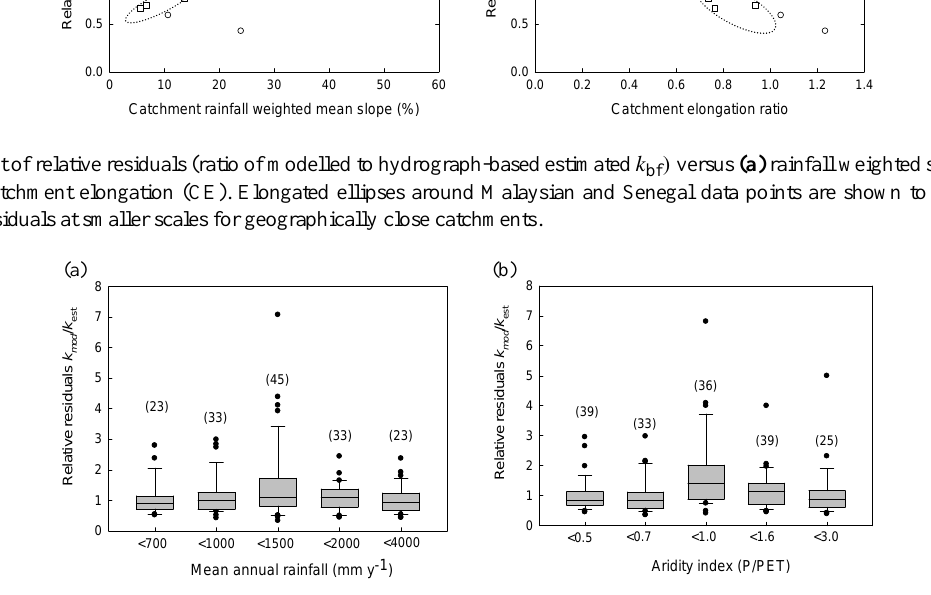
Fig. 8. Box and whiskers plot of relative residuals for exponential equations linking k bf to (a) a range of mean annual rainfall classes (MAR). (b) Idem for aridity index (AI) range. The number in brackets is the sample size per range.